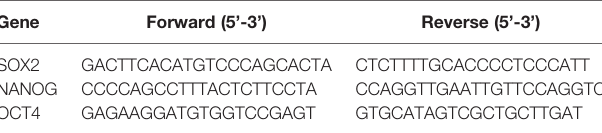
TABLE 2 | Primers in the RT-PCR